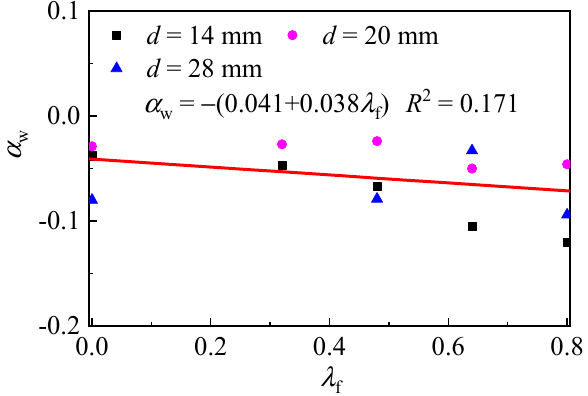
Figure 13. Change of shape coefficient α w with fiber factor. Model 4: Based on fib Model Code 2010 and China Code GB50010-2010, the typical shape of bond stress-slip curves as presented in Figure 14 was proposed by Song et al. [15]. The ascending curve was the same as Formula (5). The descending curve was presented as Formula (15) which is similar to the shape of compressive stress-strain curves of concrete in descending portion.